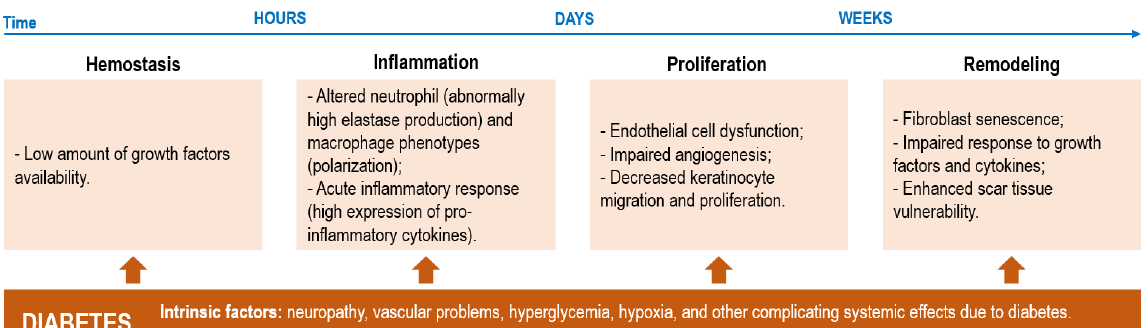
Figure 1. Possible disruptive events occurring within each phase of healing and the intrinsic and extrinsic diabetic factors that contribute to such disturbances in the normal healing cascade of wounds (adapted with CC BY 4.0 permission from [9]).